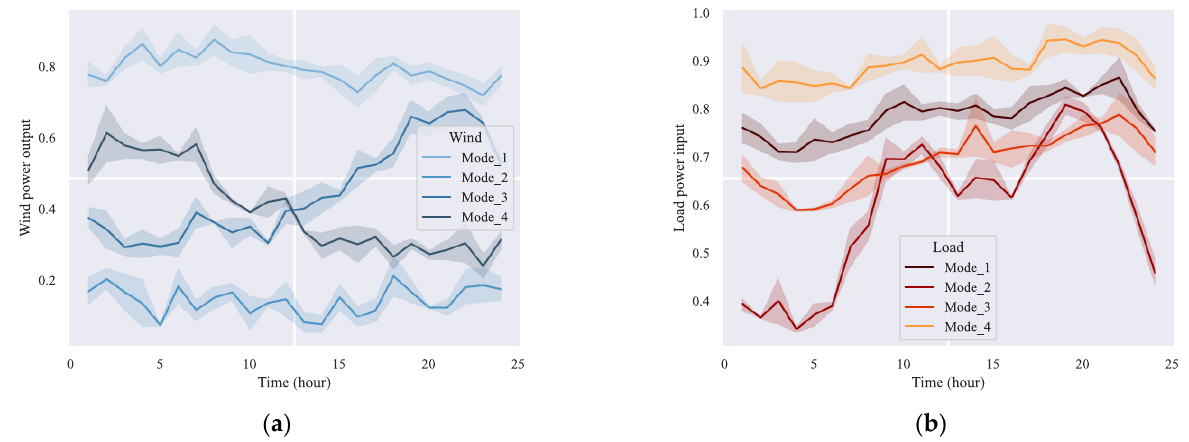
Figure 7. ( a ) The clustering results of wind power; ( b ) The clustering results of variable load.